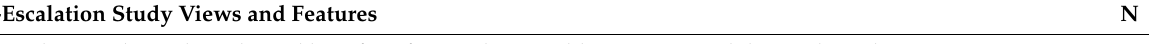
Table 4. Views on potential de-escalation